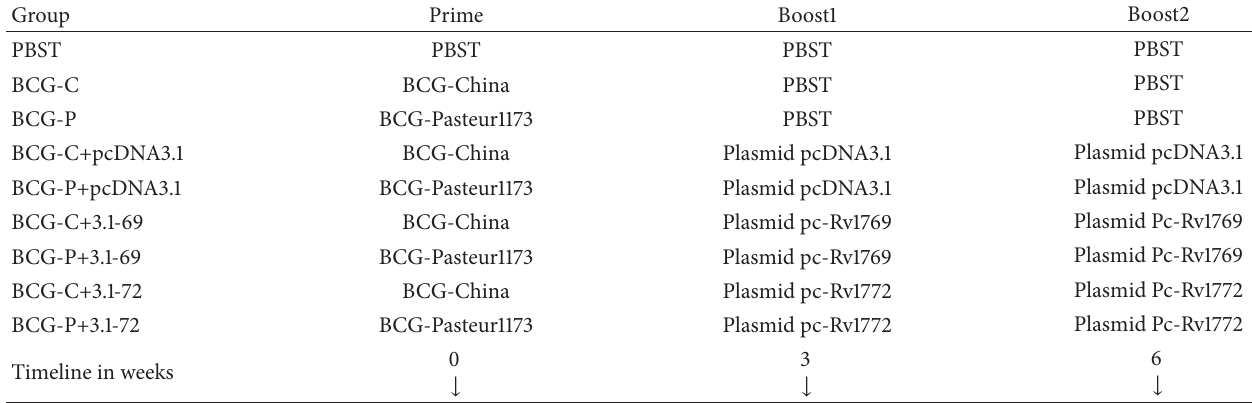
Table 1: Heterologous prime-boost immunization